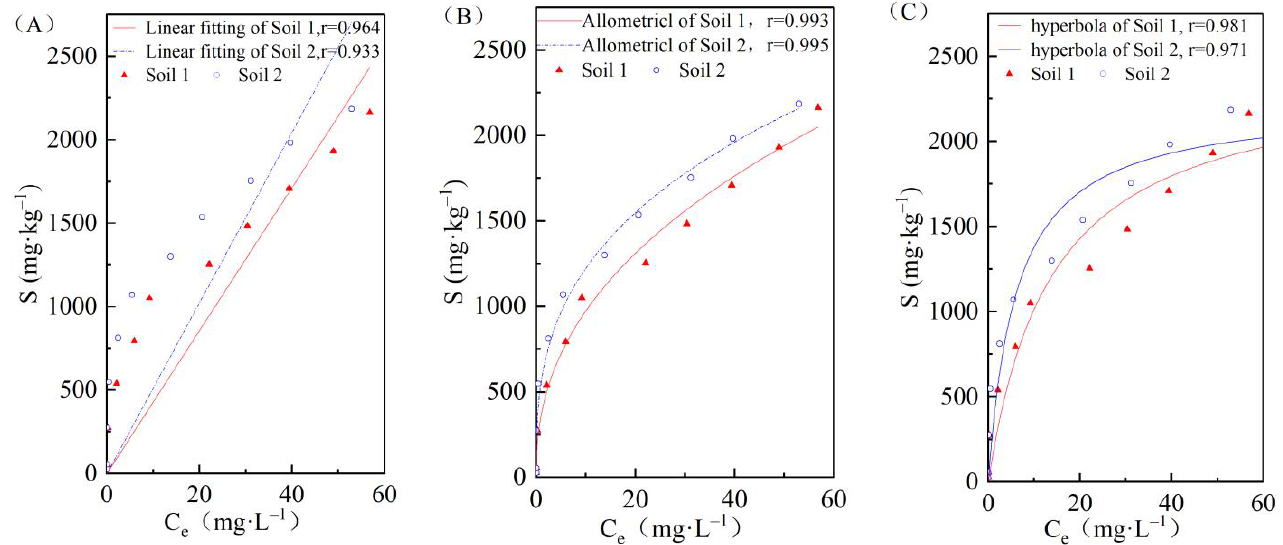
Figure 2. Changes in adsorption capacity S ( A ) and adsorption rate η ( B ) with the initial concentra- tion of solution C 0 in the two soils.